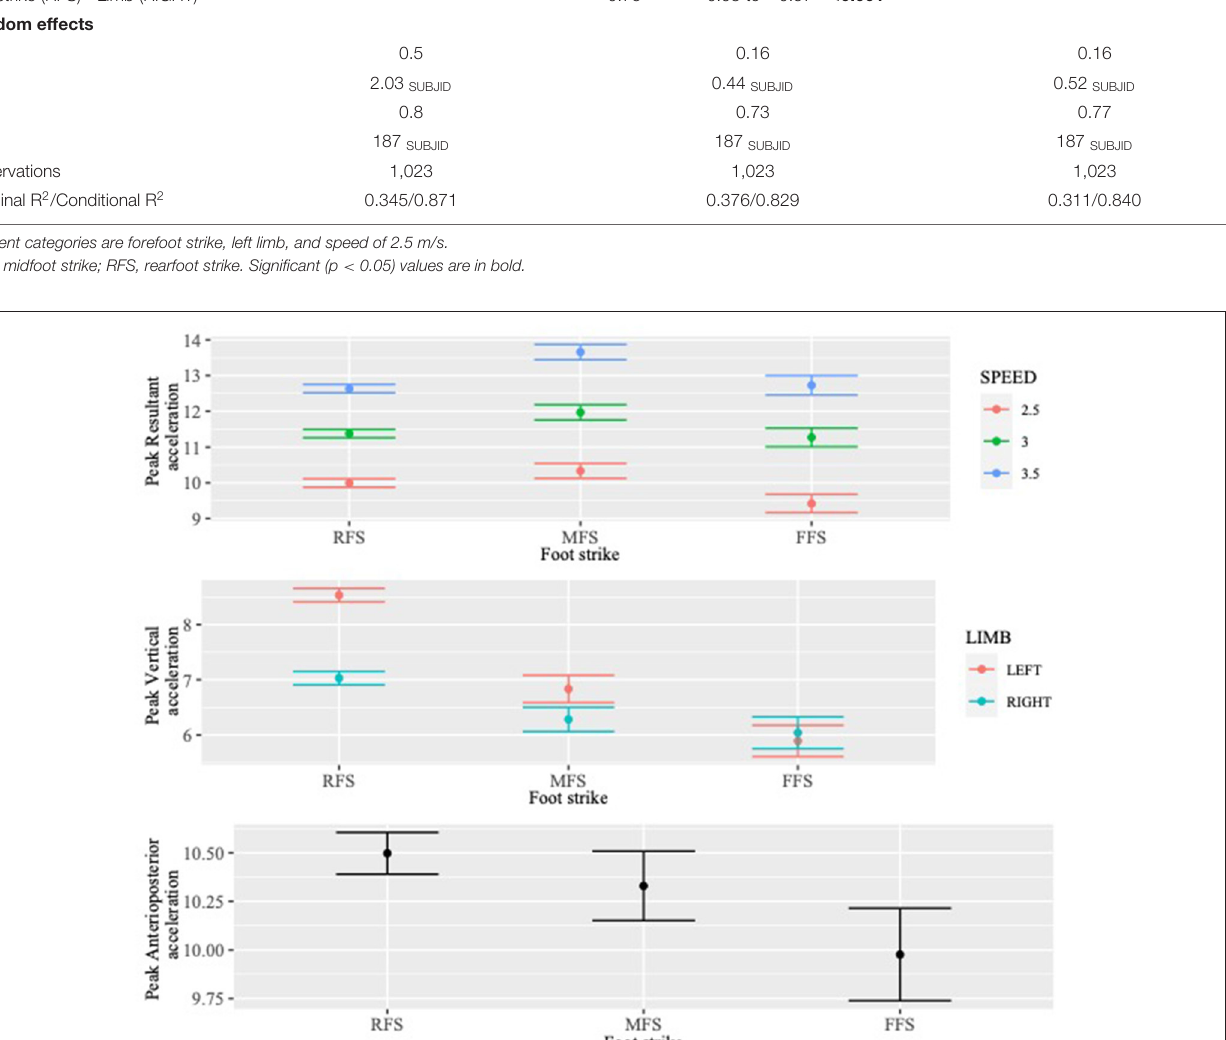
Frontiers in Sports and Active Living |